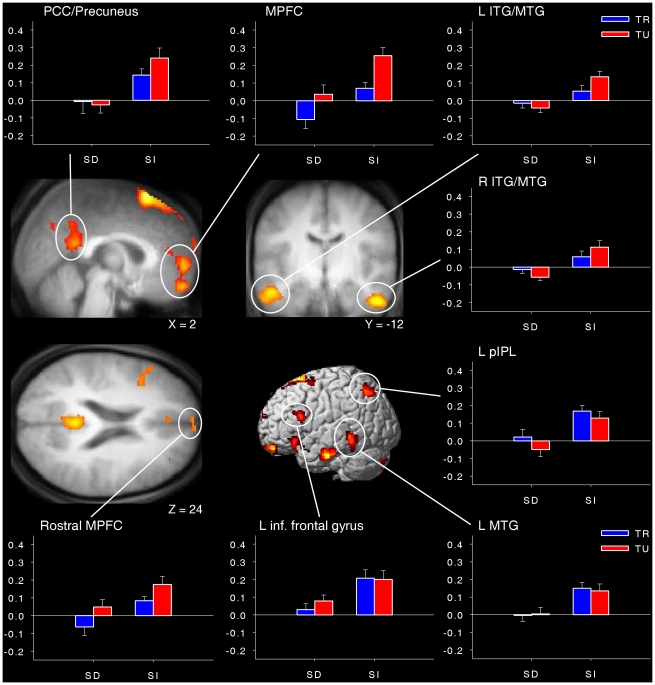
Brain areas associated with the main effect of stimulus-dependency.Regions are displayed at p<0.001, uncorrected for multiple comparisons with a minimum cluster size of 15 voxels. Bar graphs illustrate the mean parameter estimates (± standard error of the mean) for each cluster. SD = stimulus-dependent, SI = stimulus-independent, TR = task-related, TU = task-unrelated, L = left, R = right, MPFC = medial prefrontal cortex, PCC = posterior cingulate cortex, pIPL = posterior inferior parietal lobe, ITG = inferior temporal gyrus, MTG = middle temporal gyrus.